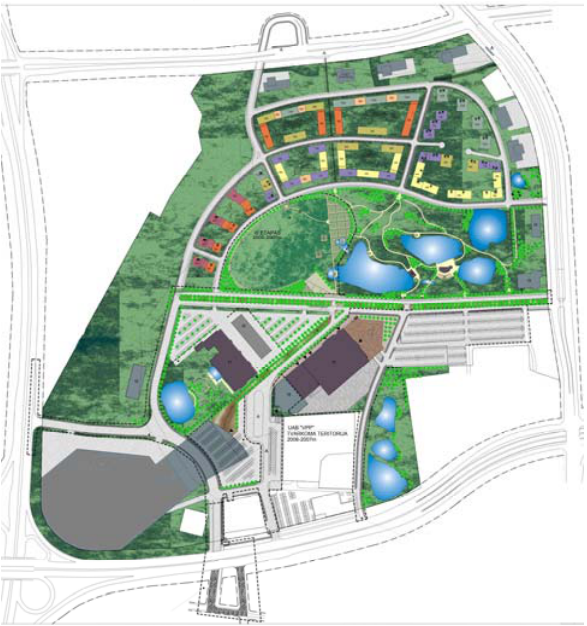
Fig 1 . Studied area in northern part of Vilnius (network of Geležinis Vilkas – Ozas – Kalvarijos str)